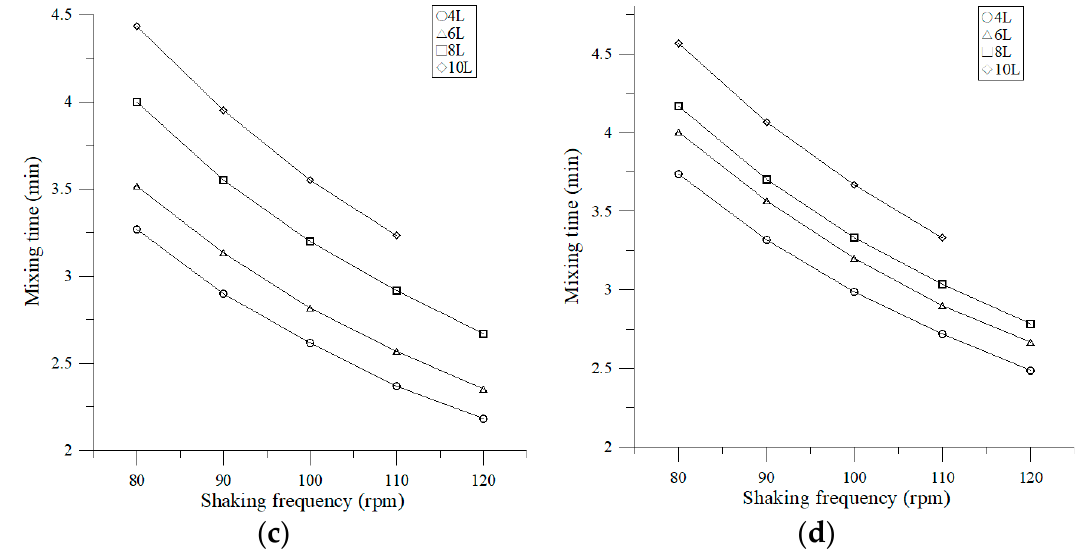
Figure 7. Effect of different shaking frequencies and filling volumes on mixing time. ( a ) Water; ( b ) 5 vol% glycerin; ( c ) 10 vol% glycerin; ( d ) 20 vol% glycerin.